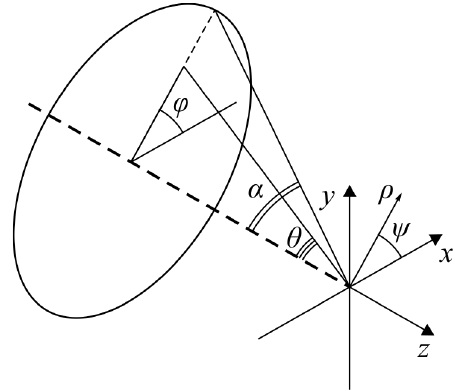
Figure 1. The geometric interpretation of the problem.